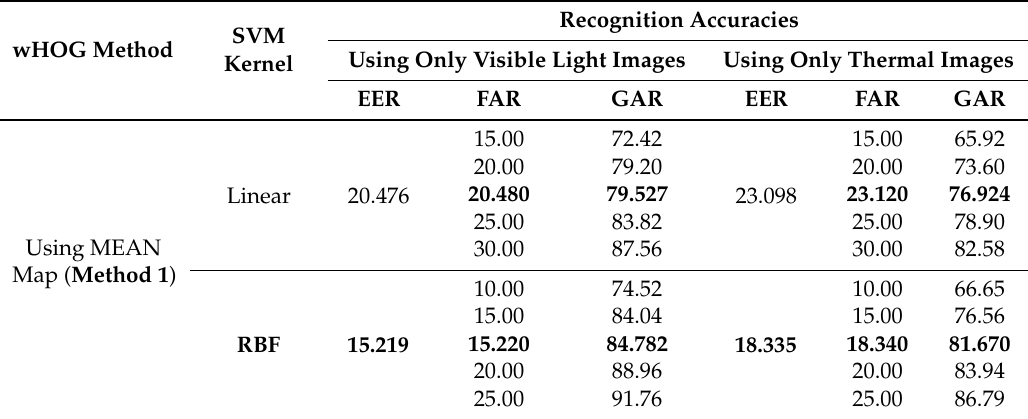
Table 6. Recognition accuracies of our proposed method using the MEAN map for the quality assessment of image regions for both visible light and thermal images (unit: